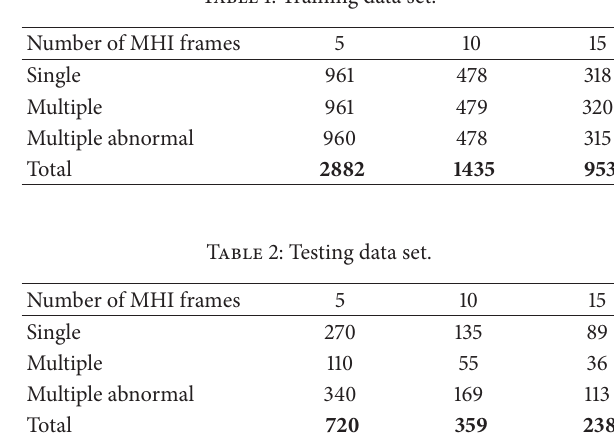
Table 1: Training data set.